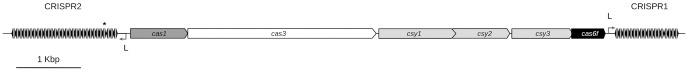
The CRISPR-Cas system detected in the ST-1146 isolates.The system was constituted by the following elements: CRISPR2, contains 29 spacers in the environmental isolates and 30 in SD9 (additional spacer indicated by*); Cas1 (cas1) endonuclease; nuclease/helicase Cas3 (cas3); 3 associated proteins Csy1 (csy1), Csy2 (csy2) and Csy3 (csy3) and a CRISPR-associated endonuclease Cas6/Csy4 encoded by the cas6f gene. The spacers (32 bp) are represented by gray rectangles between black triangles (repeats of 28 bp). The additional spacer found in the CRISPR2 of SD9 is labelled by an asterisk. Two potential leader sequences (L) of up to 244 bp are represented in front of both CRISPR loci.